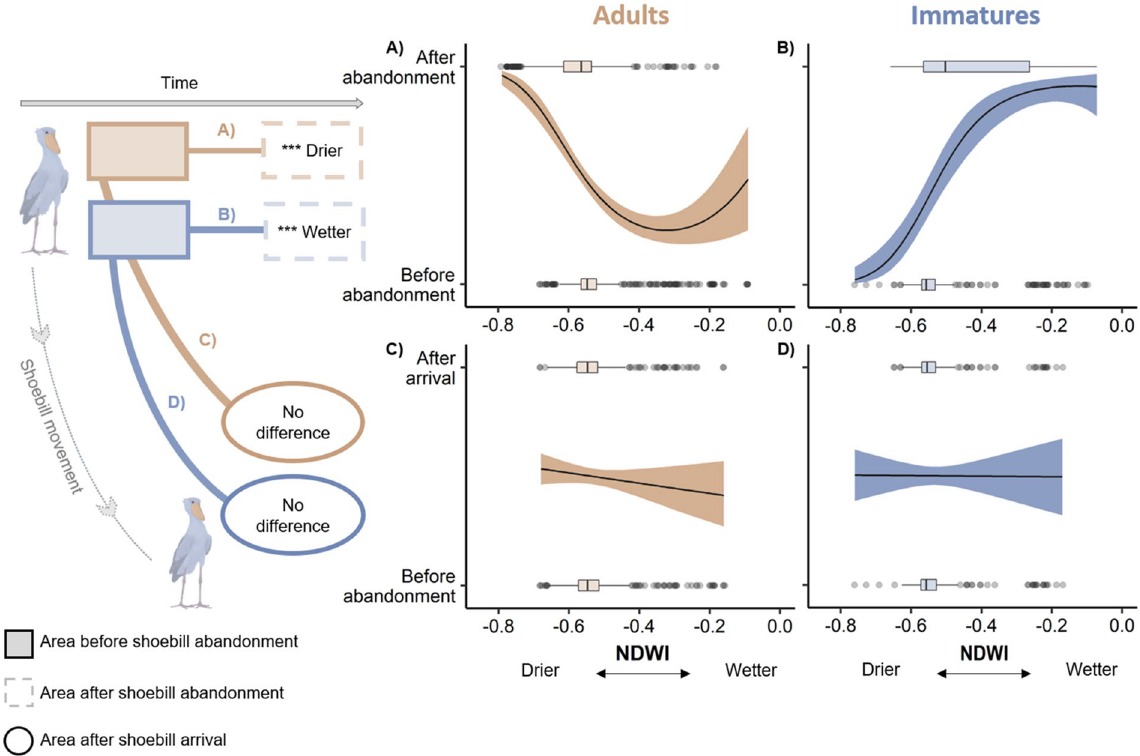
Figure 4. Diagram describing the analysed spatial and temporal relationships of Shoebill movements. The plots show the predicted mean daily NDWI values (solid line) and 95% confidence interval (shaded areas) for (A) adults and (B) immatures of ‘Areas’ before and after Shoebill abandonment, and for (C) adults and (D) immatures before Shoebill abandonment and after Shoebill arrival in a new ‘Area’. The boxplots display the observed values of daily mean NDWI, with the boxes representing the 25th, 50th and 75th percentiles and the whiskers the 1.5 times the value of inter-quantile range. Values outside this range are plotted as grey dots. Brown colours indicate adult data and blue colours indicate immature